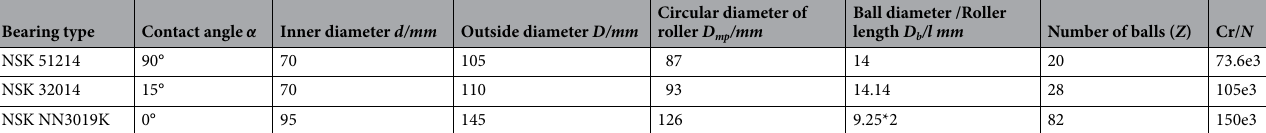
Table 2. Bearing parameters.